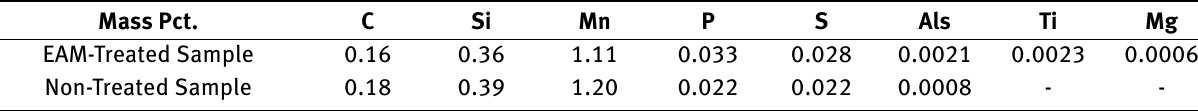
Table 1: Chemical composition of steel samples (mass percentage) Mass Pct. C Si Mn P